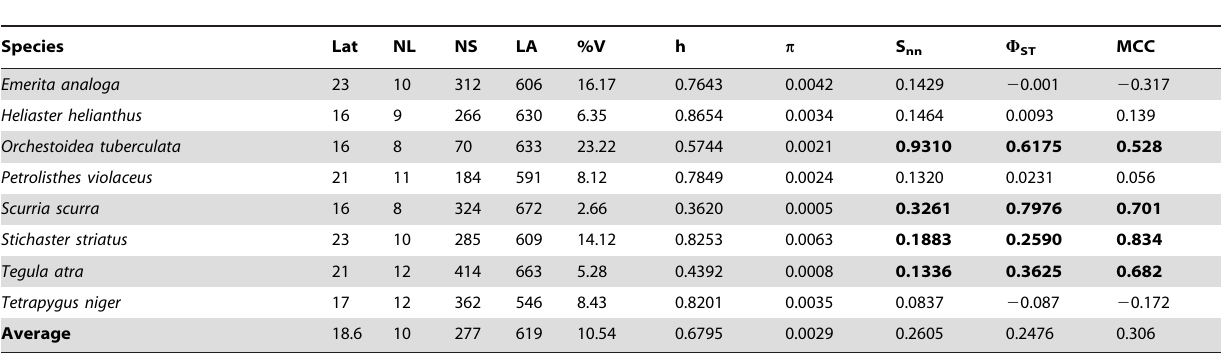
Table 2. Latitudinal range analyzed in degrees for each species (Lat); number of localities (NL); number of sequences analyzed per species (NS); length of final truncated alignment (LA); percentage of variable sites (%V); average haplotype (h) and nucleotide ( p ) diversities; S nn ; global W ST , and Mantel correlation coefficient (MCC).